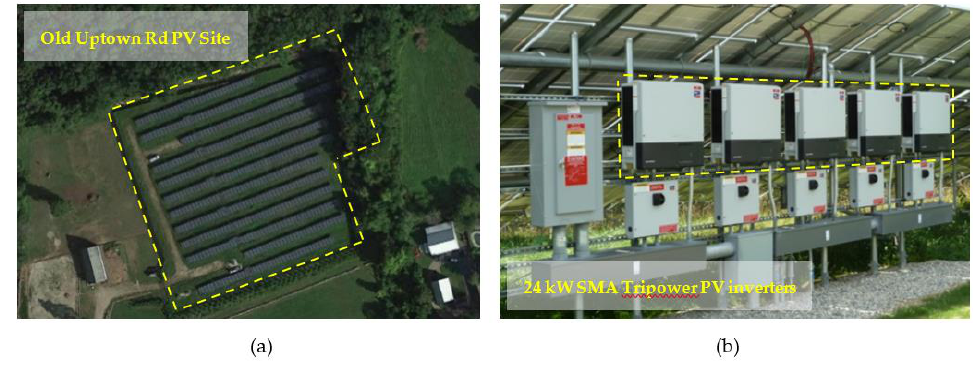
Figure 10. Field Demonstration.